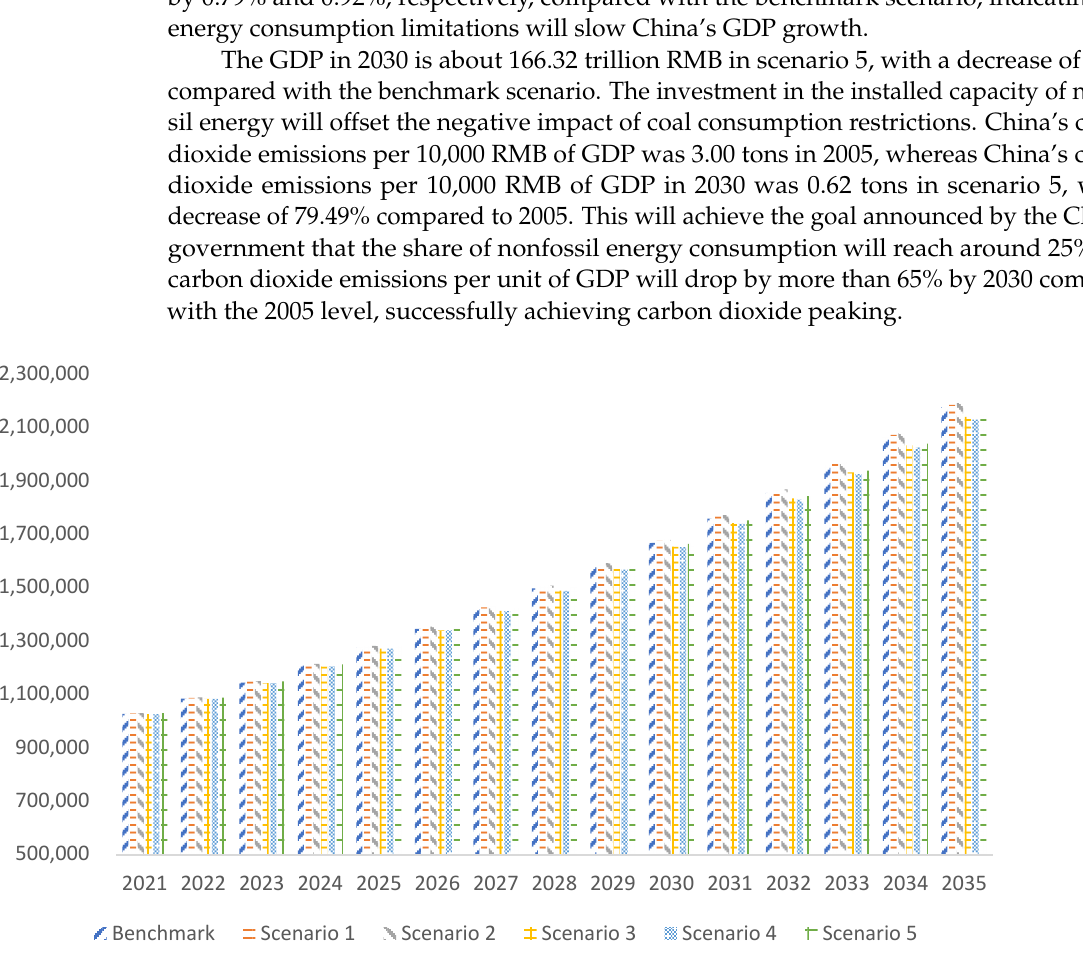
Figure 4. Carbon emissions composition of China’s energy consumption under different scenarios.